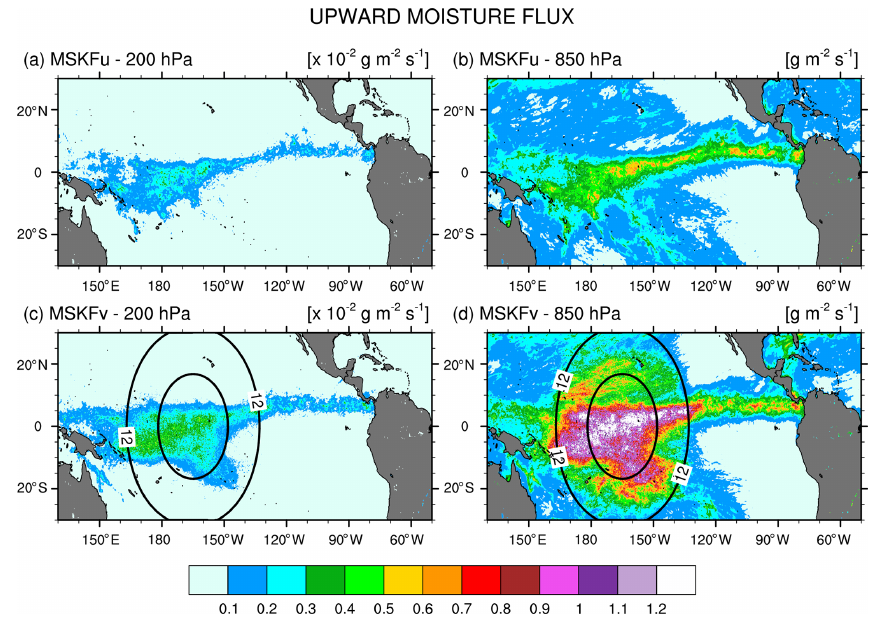
Figure 12. (a, c) 200hPa and (b, d) 850hPa monthly-mean upward moisture flux simulated with MSKF over the tropical Pacific Ocean for December 2015. Top panels (a) and (b) are for MSKFu, and bottom panels (c) and (d) are for MSKFv. Note the 1 × 10 − 2 scaling between 200 and